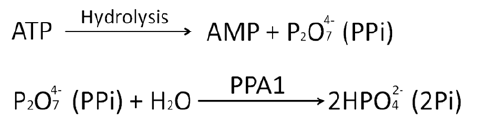
Figure 1. Generation of inorganic pyrophosphate (PPi). PPi is produced by the hydrolysis of ATP into AMP in cells. Inorganic pyrophosphatase (PPA1) catalyzes the hydrolysis of PPi to form 2 orthophosphates (2Pi), resulting in energy release.